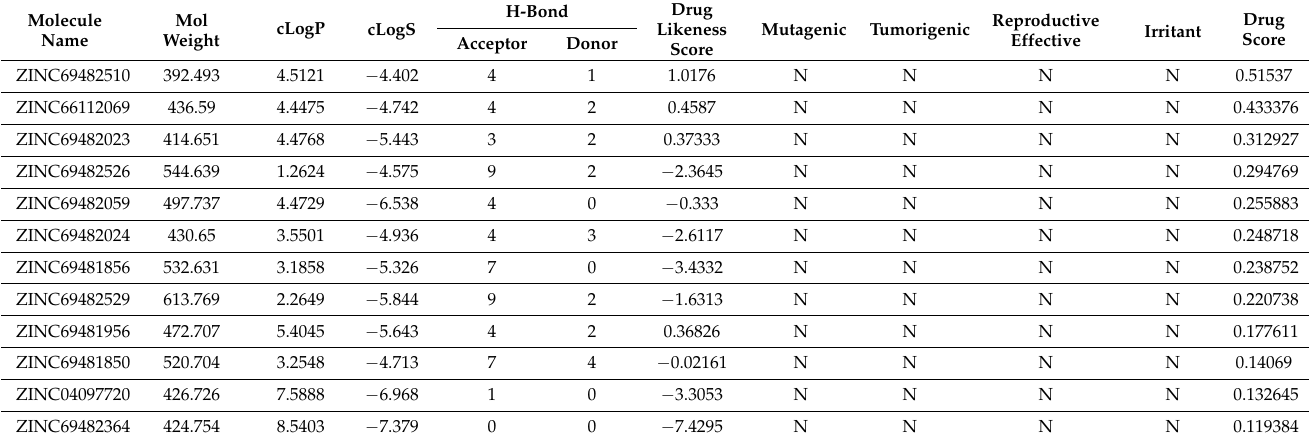
Table 2. Physicochemical and drug-likeness properties of selected